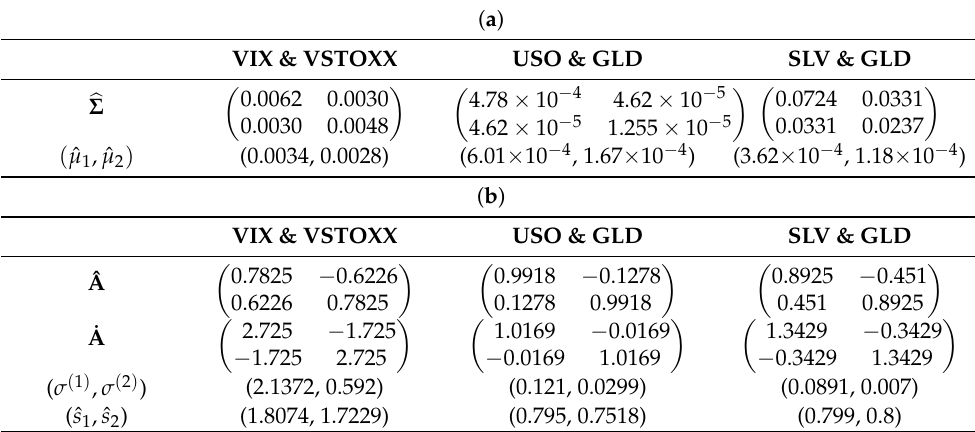
Table 1. Empirical results ( a ) covariance matrix and long term average of squared volatility indexes; ( b ) eigenvectors, eigenvalues and scaling